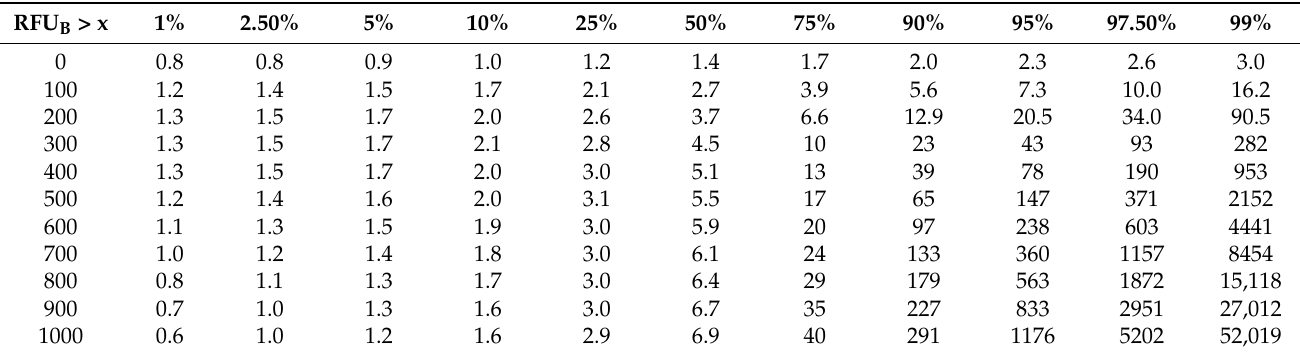
Table 6. Activity level likelihood ratios, with sensitivity analysis, showing 1–99 percentiles. The median (50 percentile) values are those that are reported. Results for the discrete model are shown in the top row; continuous model conditioned upon RFU B > x shown in remaining